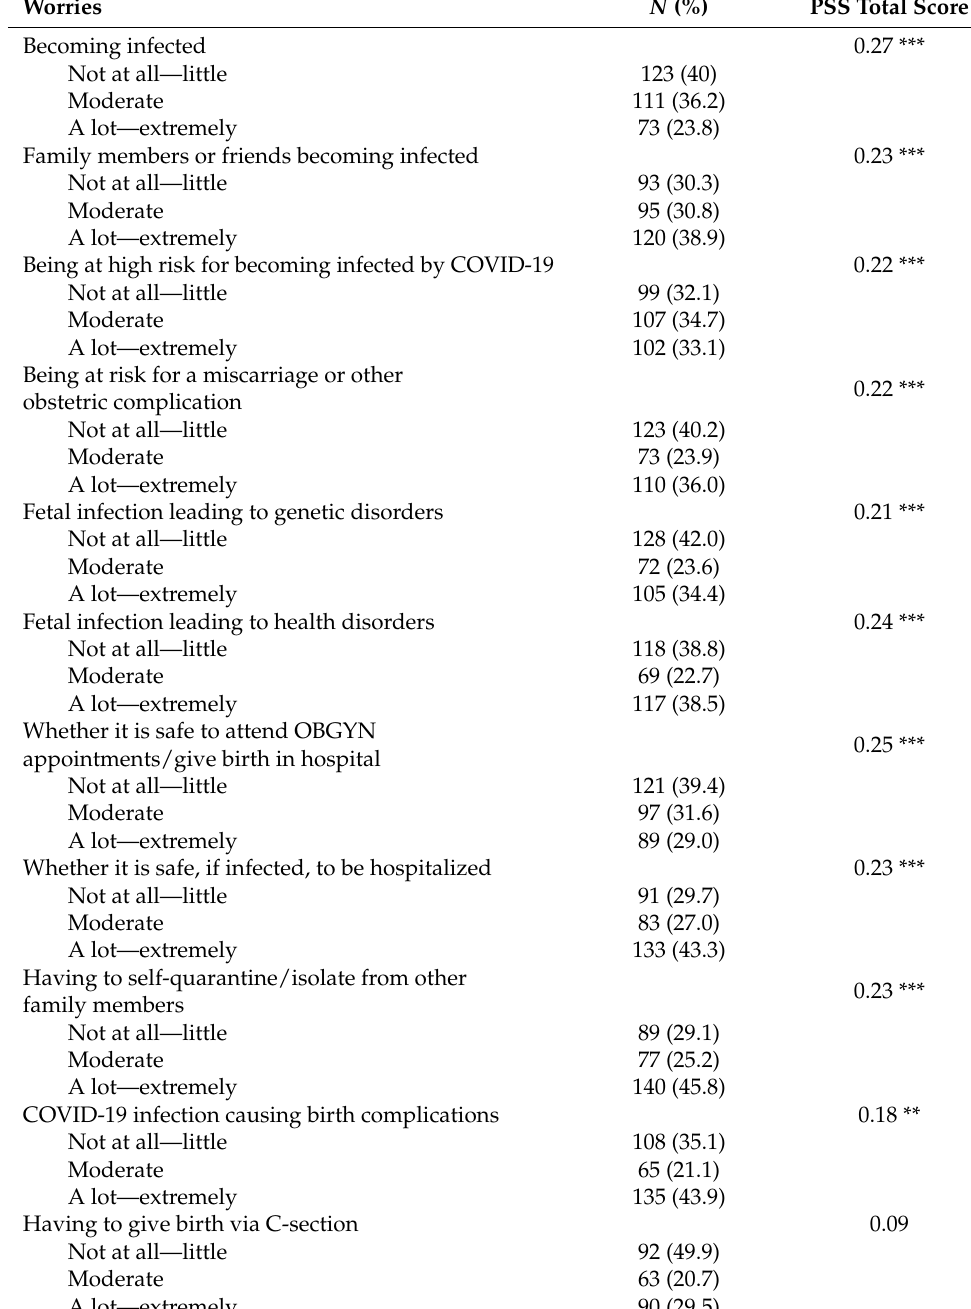
Table 3. Worries related to COVID-19 and bivariate correlations between worries and PSS a for the total sample ( N =